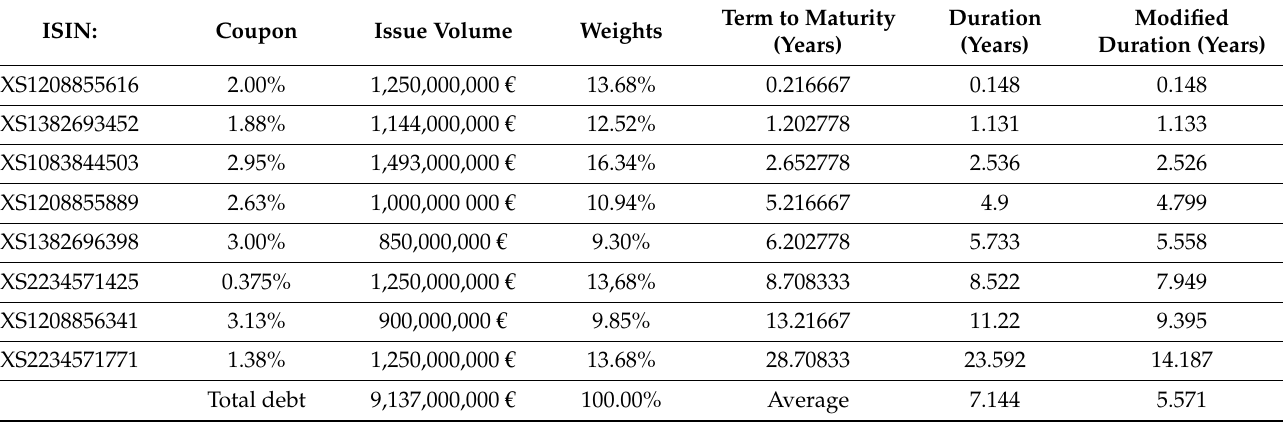
Table 14. Bulgarian’s Sovereign Bonds